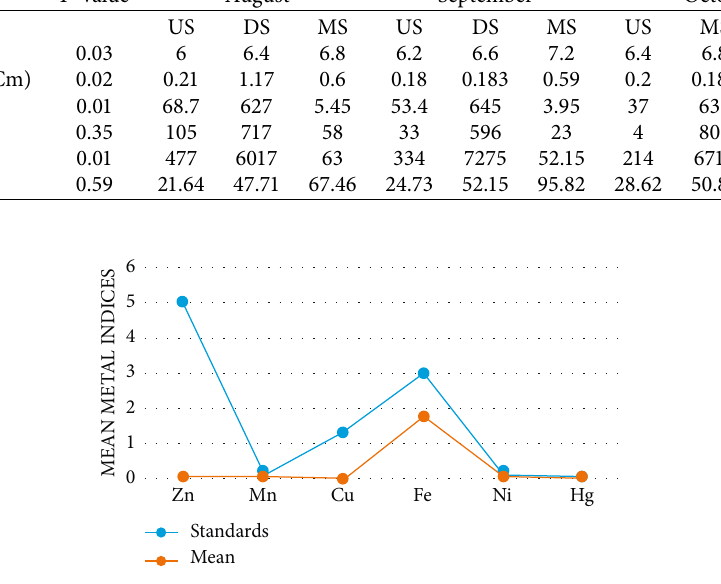
Figure 5: Mean pollution index of heavy metals compared with standard concentrations.